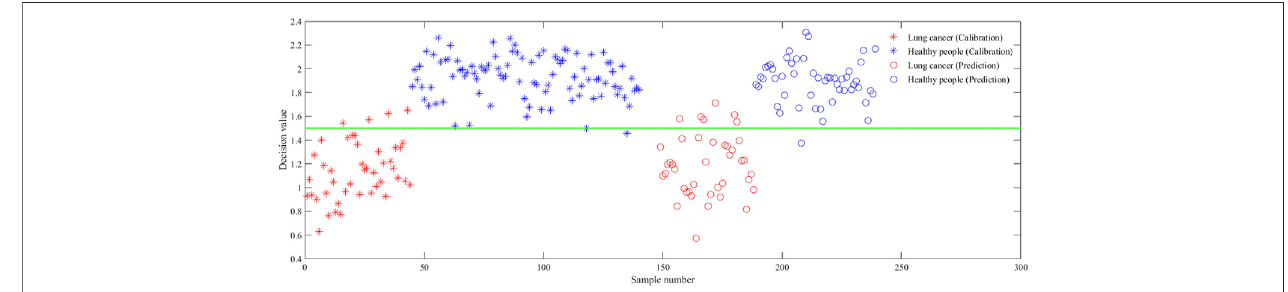
FIGURE 5 | Score plot of the PLS-DA model using data fusion combined with